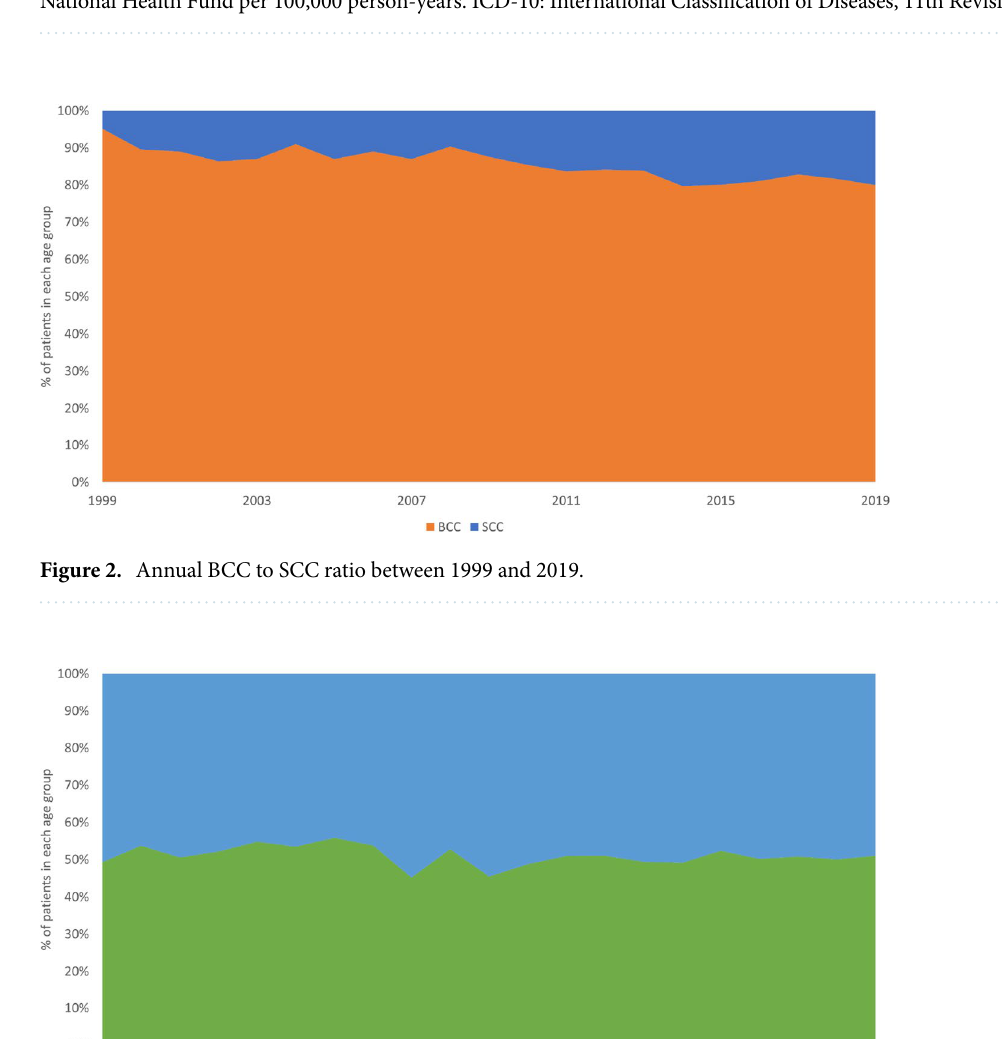
Figure 1. Incidence of cases diagnosed using ICD-10 code C44 between 1999 and 2019 according to the Polish National Health Fund per 100,000 person-years. ICD-10: International Classification of Diseases, 11th Revision.